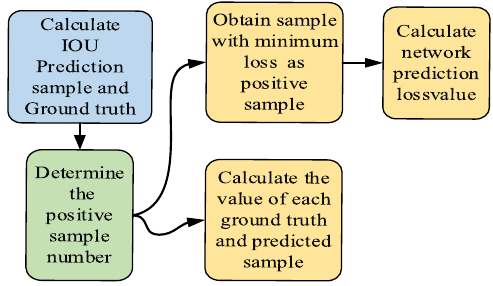
Figure 8. The computational processes of simOTA.